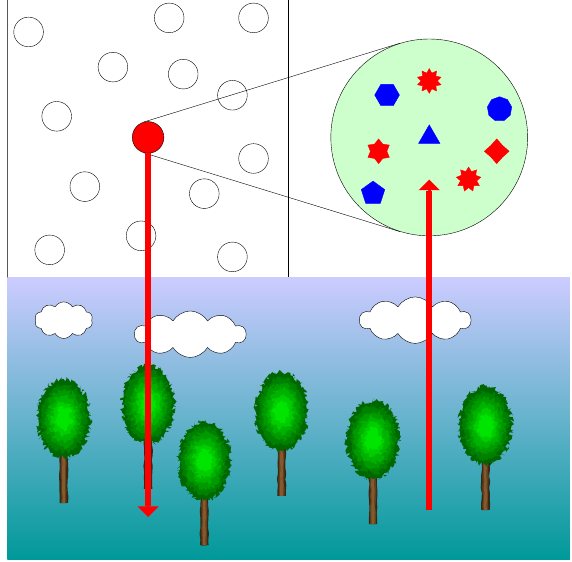
Fig. 4. Immuno-epidemiological modeling with environmen- tal